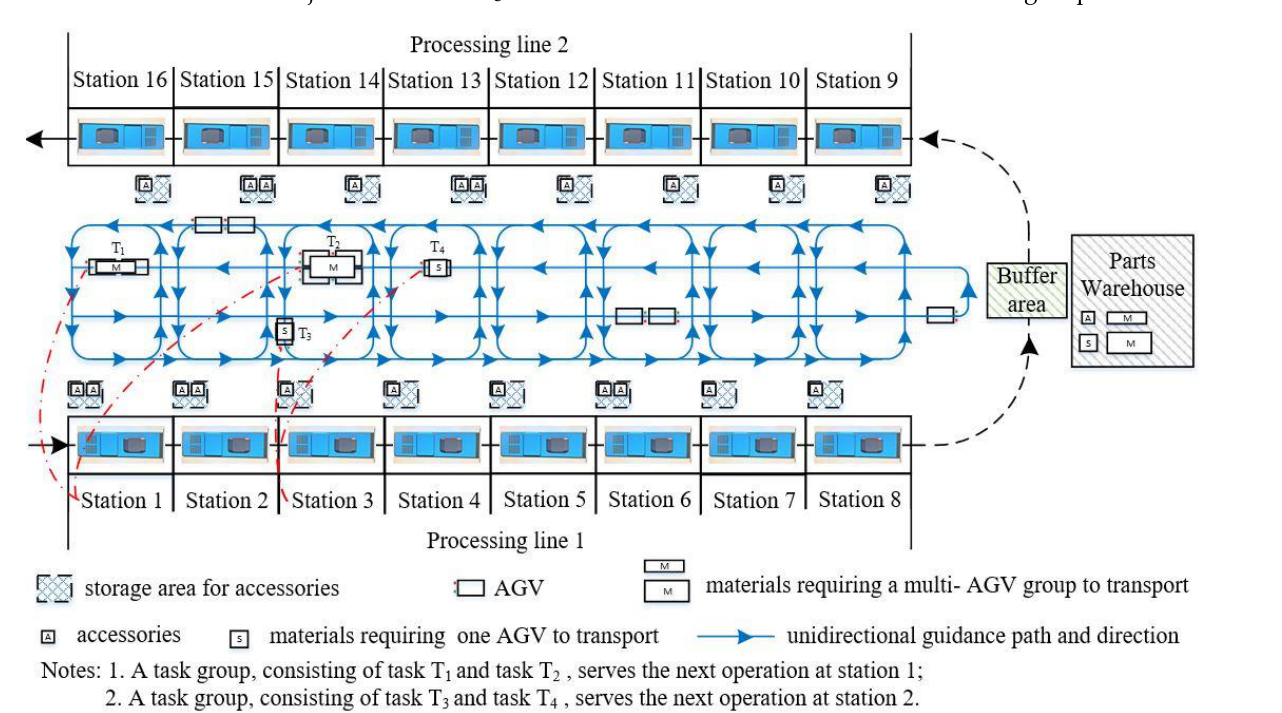
Table 1. The notations used in the study.